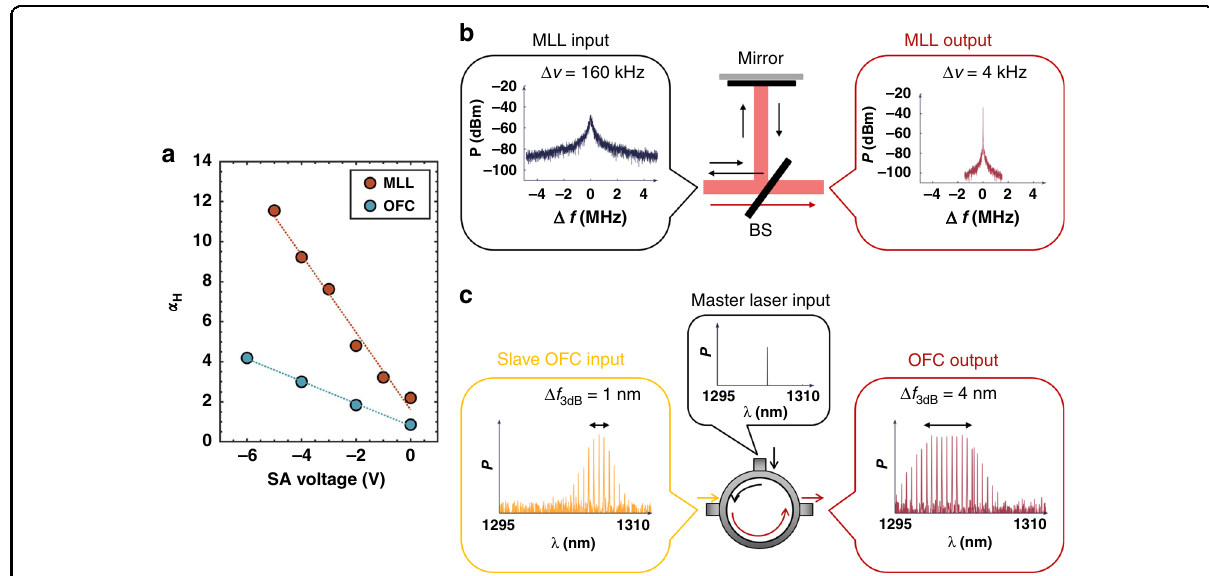
Fig. 10 Optical frequency combs. ( a ) The α H factor measured at threshold as a function of the SA reverse voltage of the MLL (burgundy) and OFC (jade). ( b ) Sketch of the optical feedback stabilization operation of a QD-MML in the frequency domain. BS, beam splitter. ( c ) Sketch of the optical injection operation of a